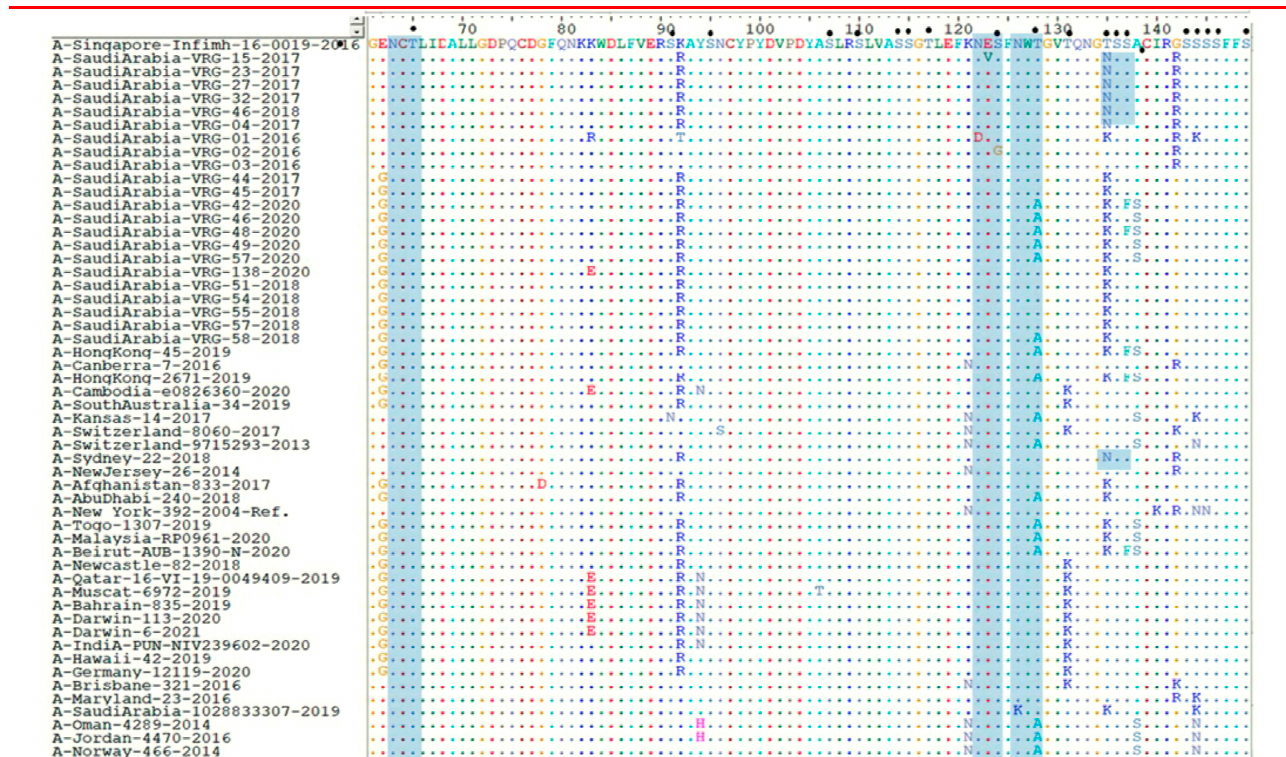
Note: red alphabets: sites where amino acid changes occur.